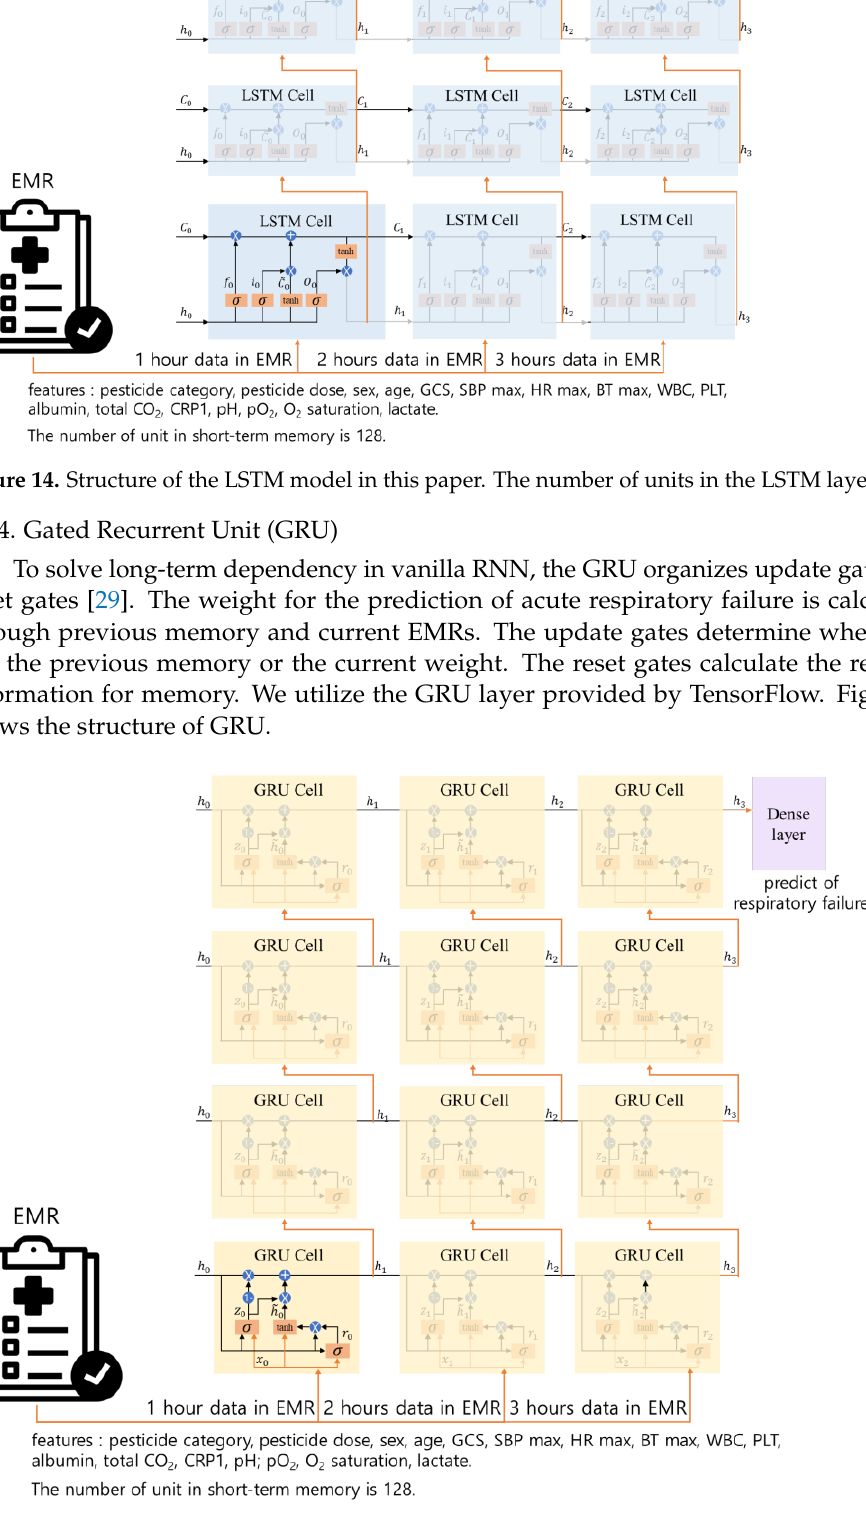
Figure 15. Structure of the GRU model in this paper. The number of units in the GRU layer is 128.